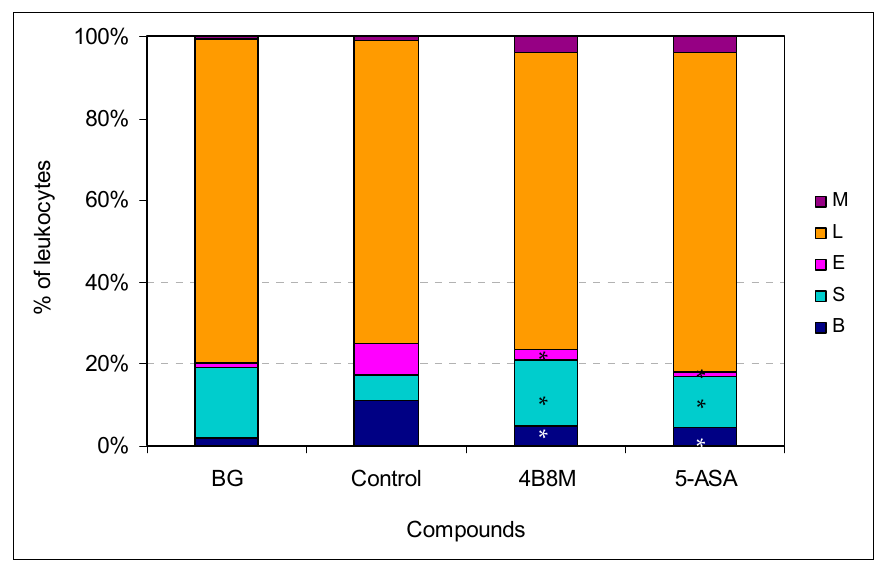
Figure 8. Effect of the preparations on blood cell type composition in mice with chemically induced colitis: the experiment was performed as described in Figure 7. On day 12 of the experiment, the mice were bled and the smears evaluated; up to 100 cells were counted per preparation. The results are presented as the percentages of main cell types: mature neutrophils (segments, S), neutrophil precursors (bands, B), eosinophils (E), lymphocytes (L), and monocytes (M). Mean values for each group are shown. * Control vs. compounds p < 0.05 (ANOVA).